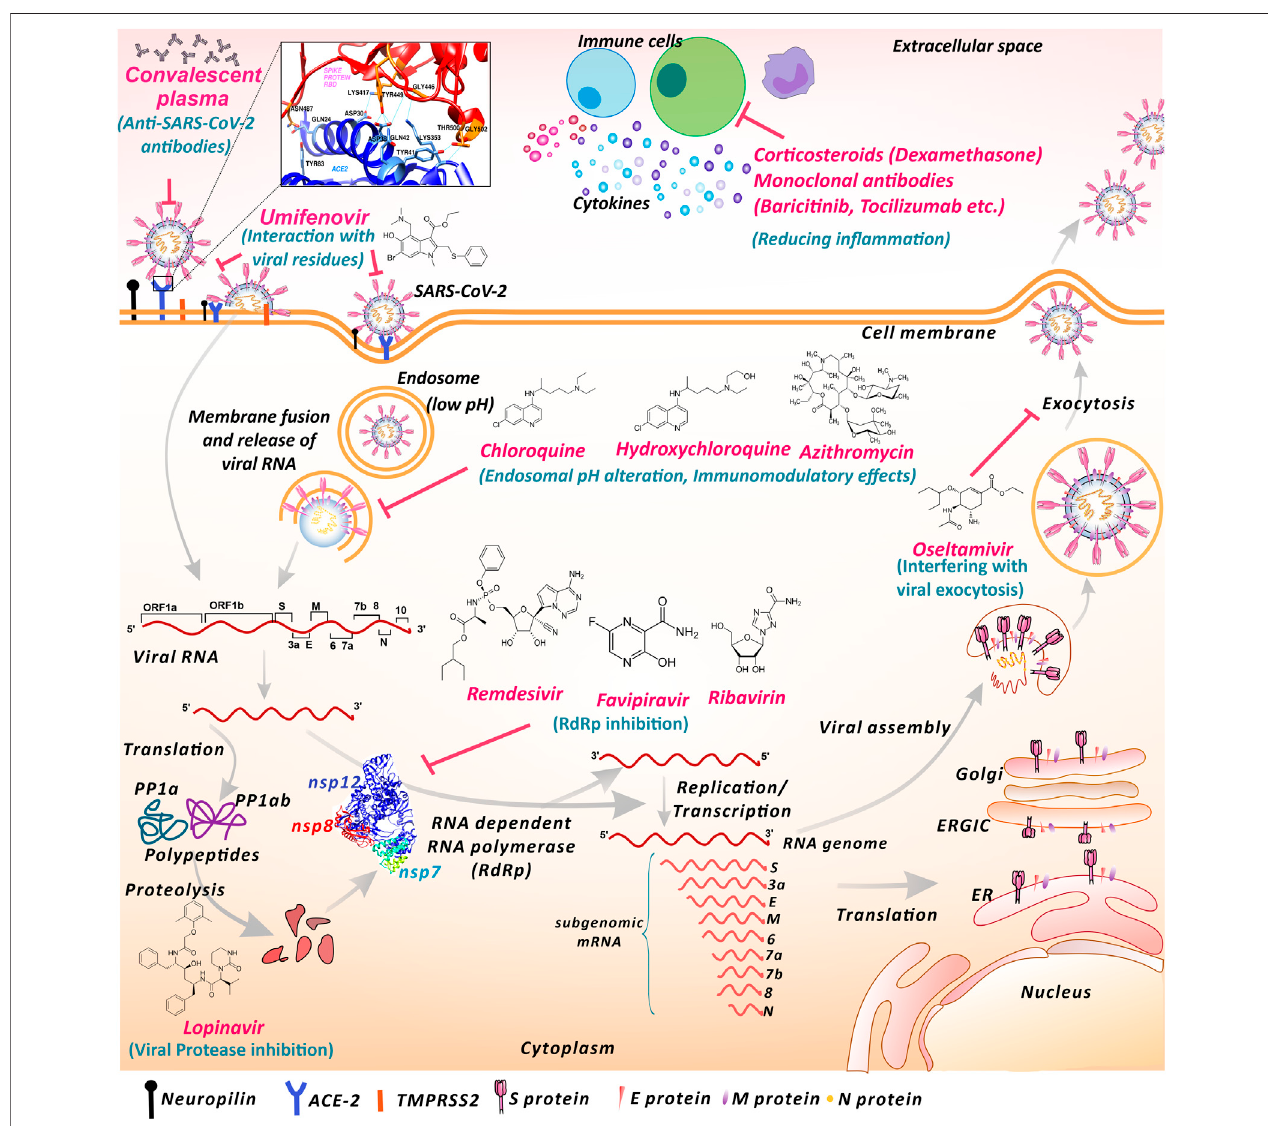
FIGURE1| Proposedmechanismsofrepurposed drugsand therapiesusedagainstSARS-CoV-2infection. SARS-CoV-2interactswithcellsurfacereceptors like ACE-2 and neuropilin to gain entry inside the cell. Umifenovir may interact with SARS-CoV-2 surface glycoproteins and lipids and obstruct the interaction with the entry receptor ACE-2. Anti-SARS-CoV-2 antibodies present in convalescent plasma may inhibit SARS-CoV-2 entry and subsequent infection transmission. Chloroquine, hydroxychloroquine and azithromycin may elevate endosomal pH and hinder viral entry and RNA release process. Chloroquine, hydroxychloroquine and azithromycin also shows immunomodulatory effects. Nucleoside inhibitors like remdesivir, favipiravir and ribavirin may inhibit RNA replication and suppress RNA- dependent RNA polymerase activity. Lopinavir may fraternize with viral protease altering the proteolysis. Oseltamivir may interplay with components involved in the exocytosis process, blocking the viral exit from the cell. Monoclonal antibodies against cytokine receptors and Corticosteroid shows anti-in fl ammatory actions against exaggerated immune response. (ACE-2-Angiotensin-converting enzyme 2, TMPRSS2 Transmembrane Serine protease 2, RdRp- RNA dependent RNA polymerase, ER- Endoplasmic reticulum, ERGIC- Endoplasmic reticulum-golgi intermediate complex. The displayed ACE-2-Spike interaction residues and RdRp structures are based on Protein databank structure ID: 6M0J and 6M71 respectively).